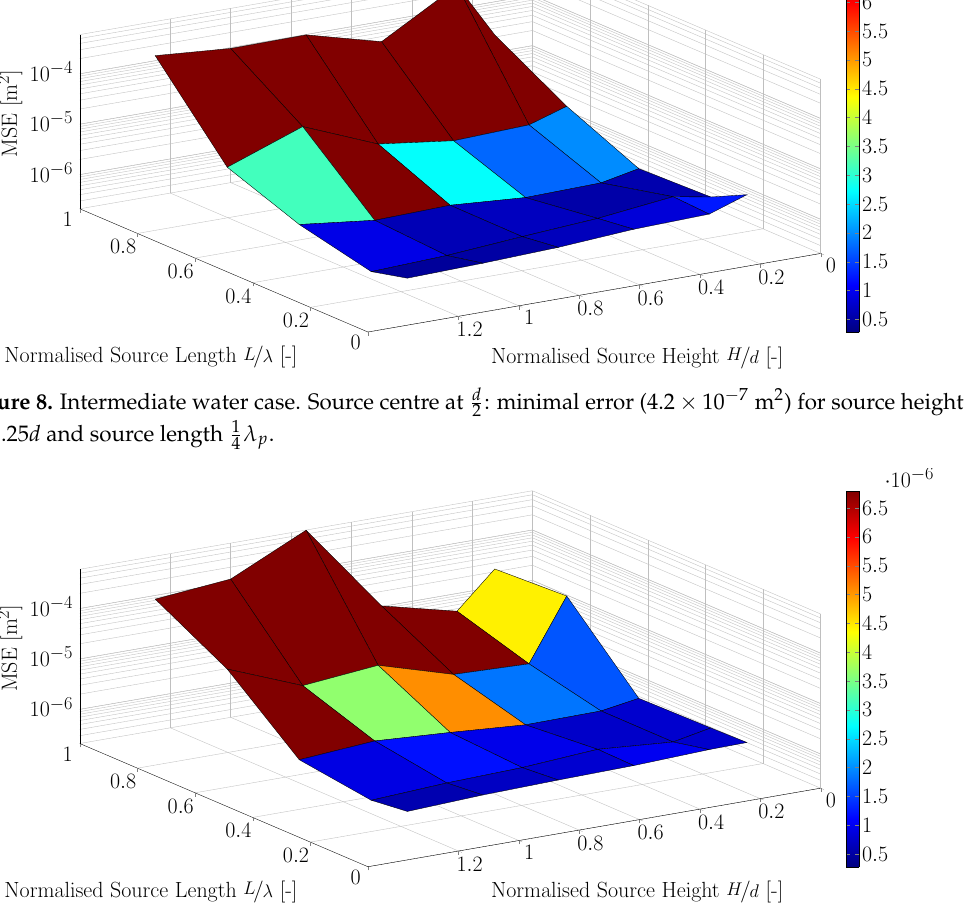
: minimal error (5.9 3